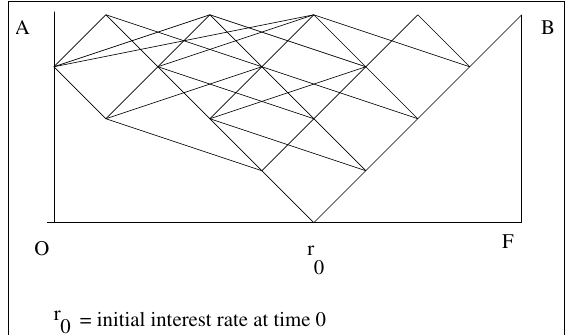
Figure 3. Embedding the tree structure into the stochastic control